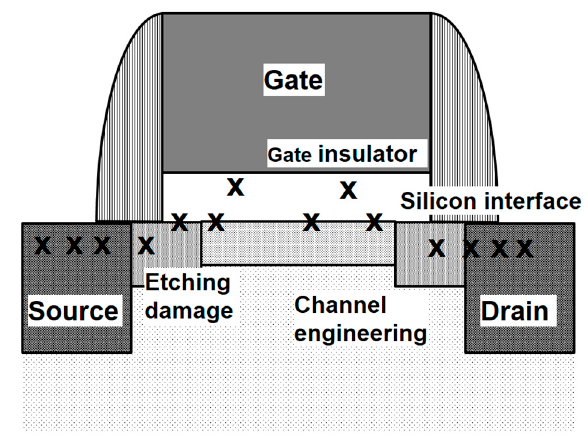
Figure 4. Defects that influence the source follower device noise.